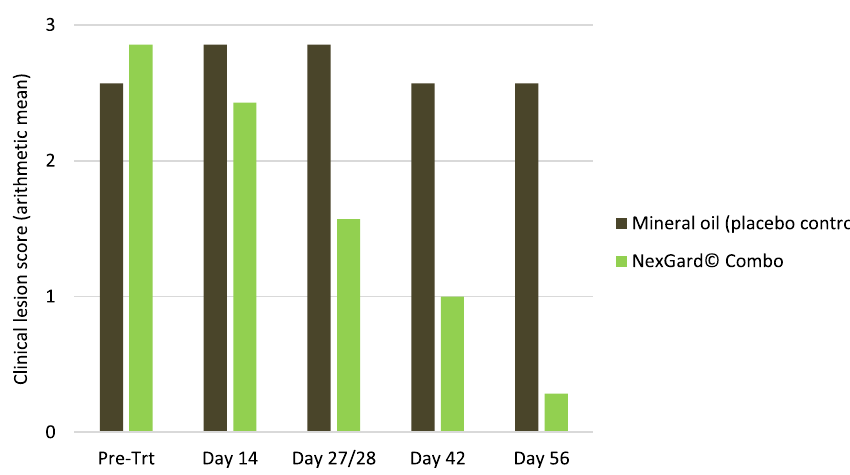
Figure 1. Summary of clinical mange scores per group for each observation